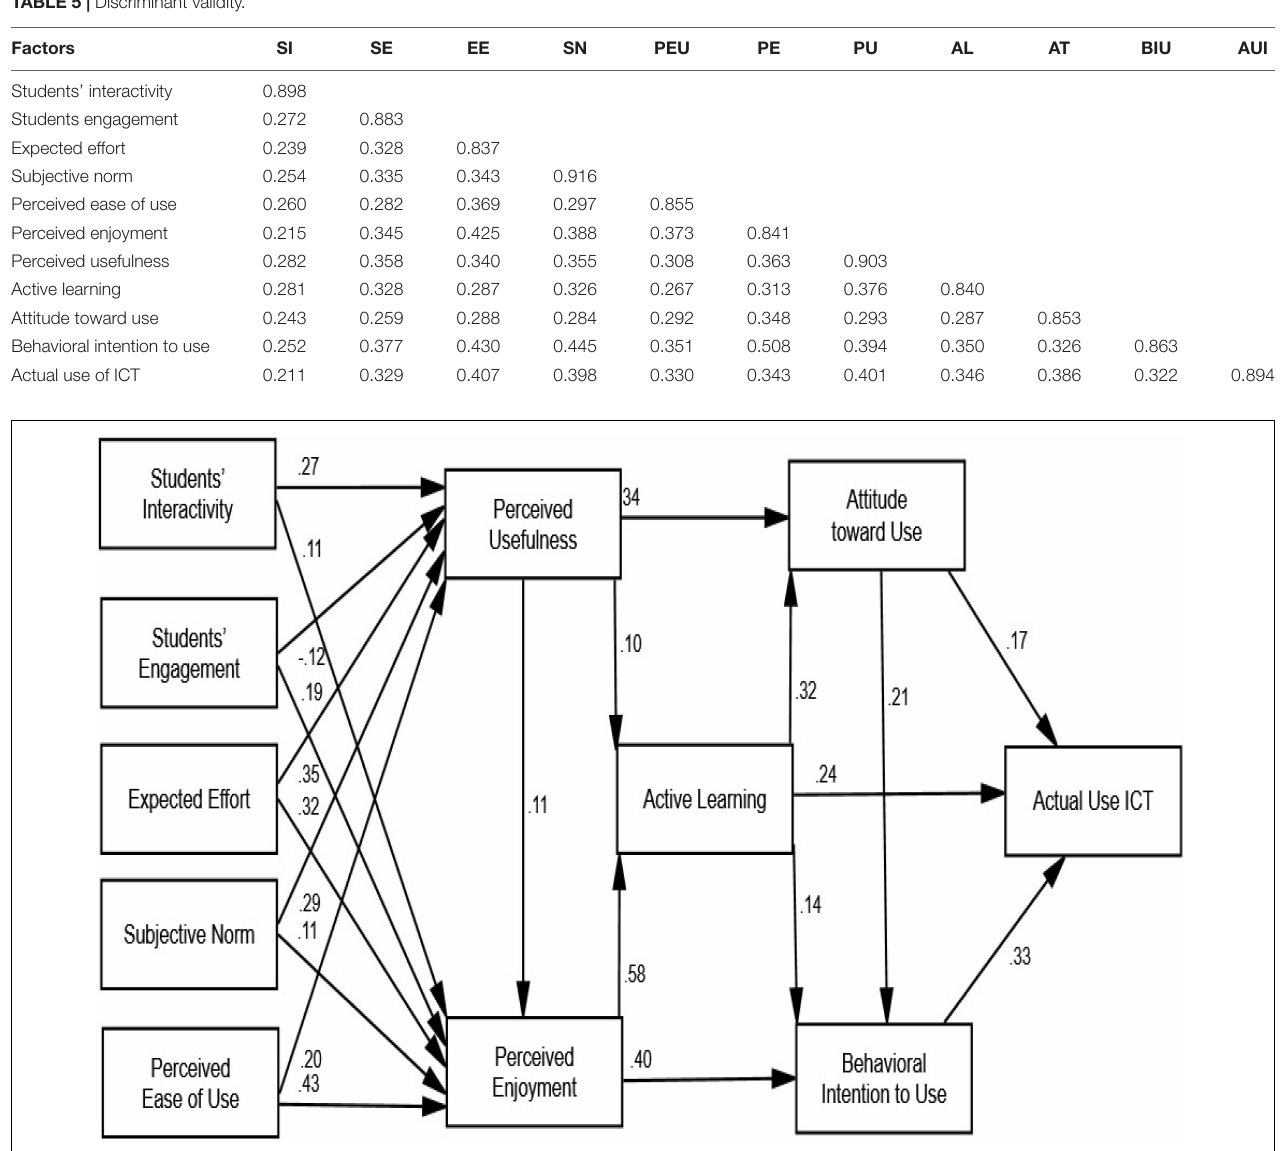
FIGURE 3 | Path coefficient